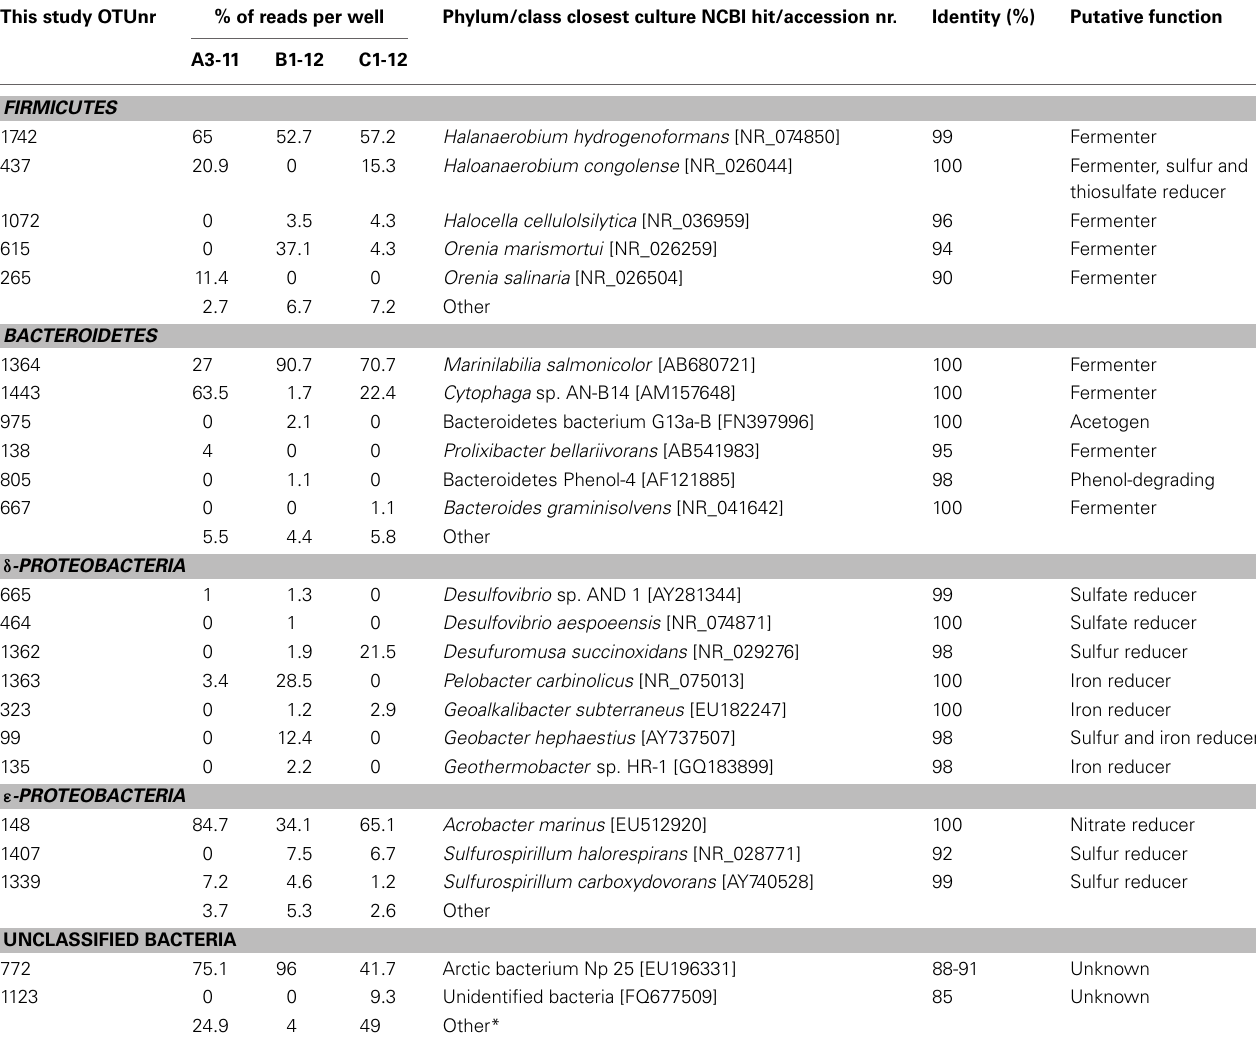
Table 2 | Relative abundance (% of total Illumina reads) OTUs recovered from the initial formation waters of the A3-11, B1-12, and C1-12 wells. This study